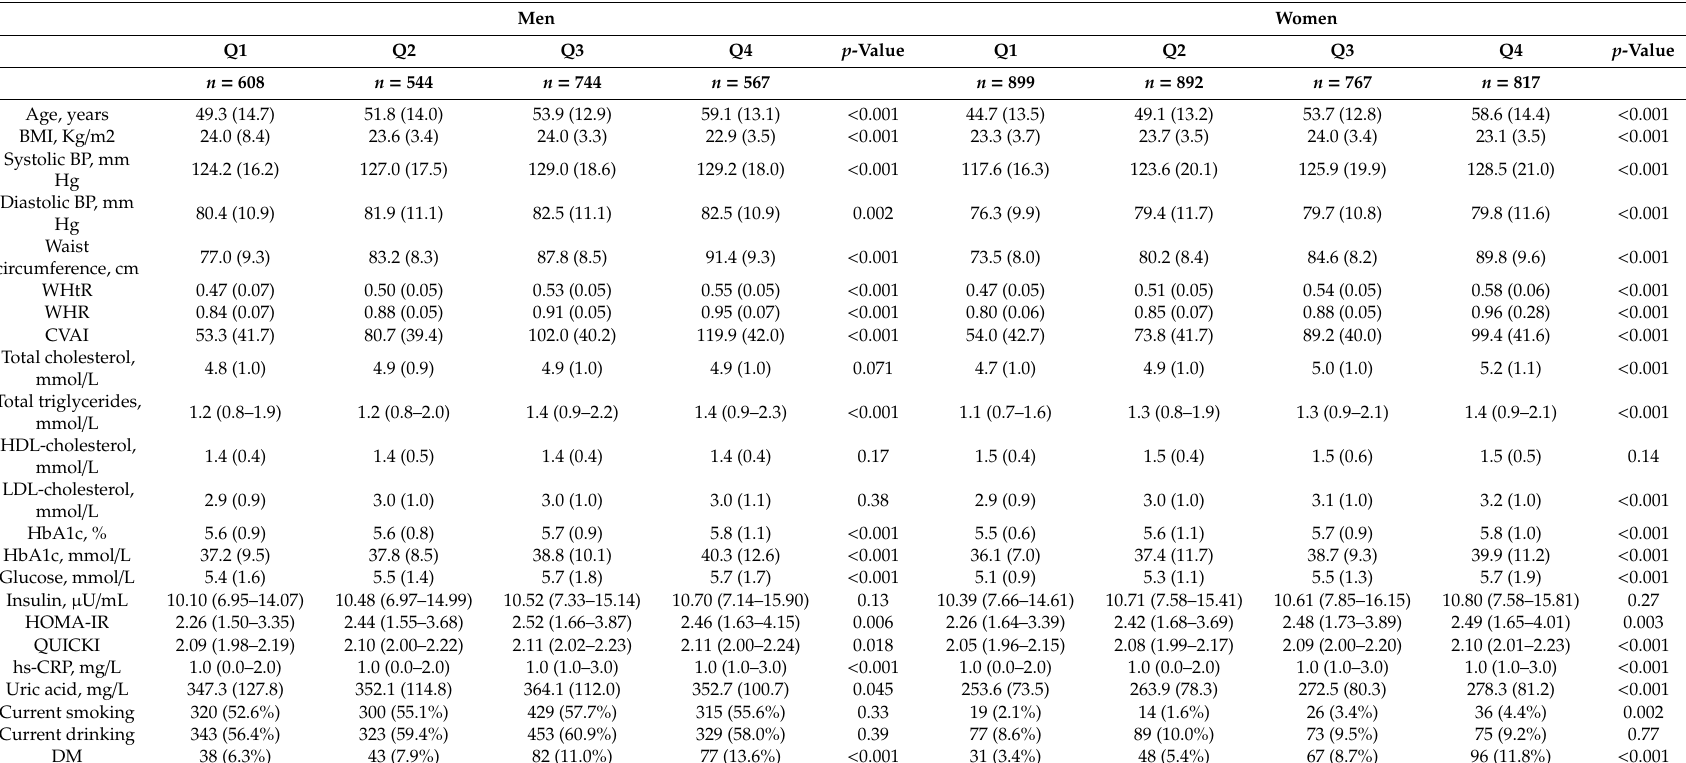
Table 2. Characteristics of participants by body shape index (ABSI) among men and women in China ( n =